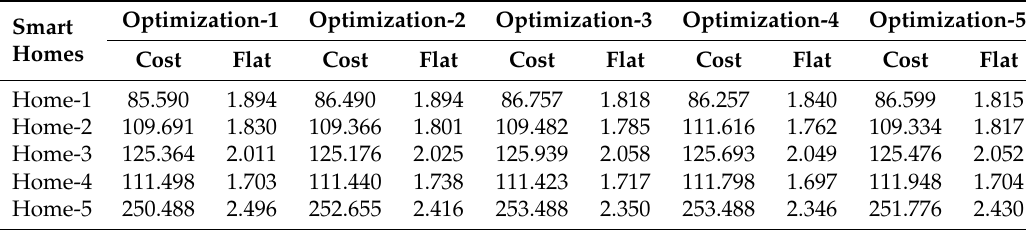
Figure 3. Possible energy optimizations in smart homes. Table 5. Possible optimization results.